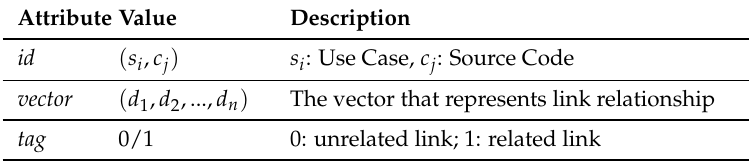
Table 2. The definition of a link between a use case and a source code